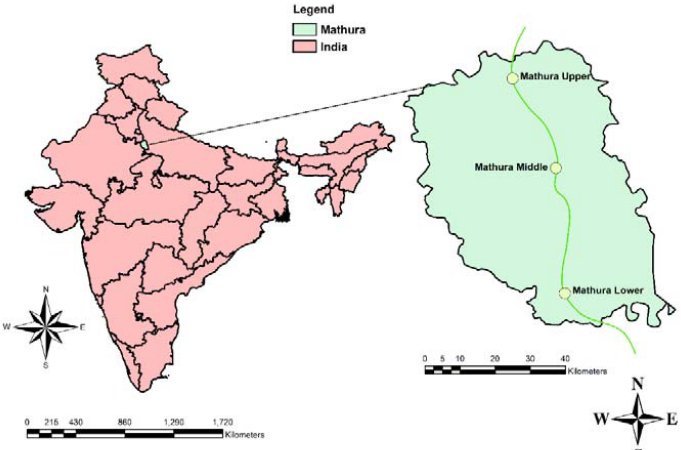
Fig. 1: Geographic location of the study area of Mathura along Yamuna